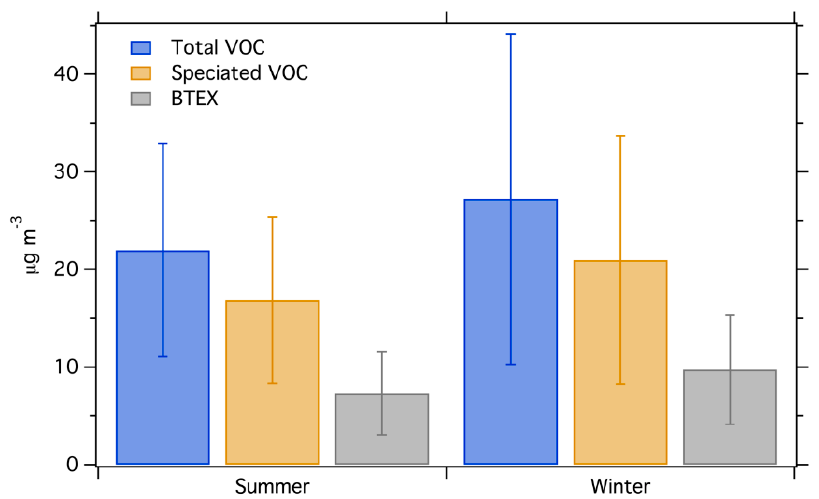
Figure 6. Seasonal variation of total VOC, speciated VOC and BTEX concentrations for Phase I dataset. Error bars show one standard deviation.